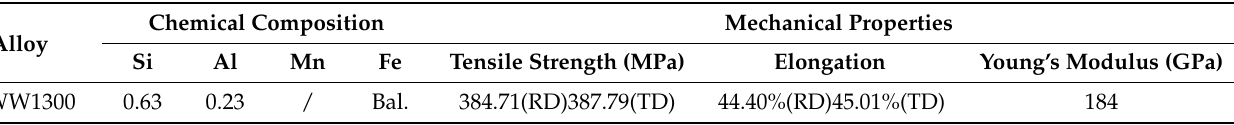
Table 1. Nominal chemical composition and mechanical properties (obtained by tensile tests) of 50WW1300.